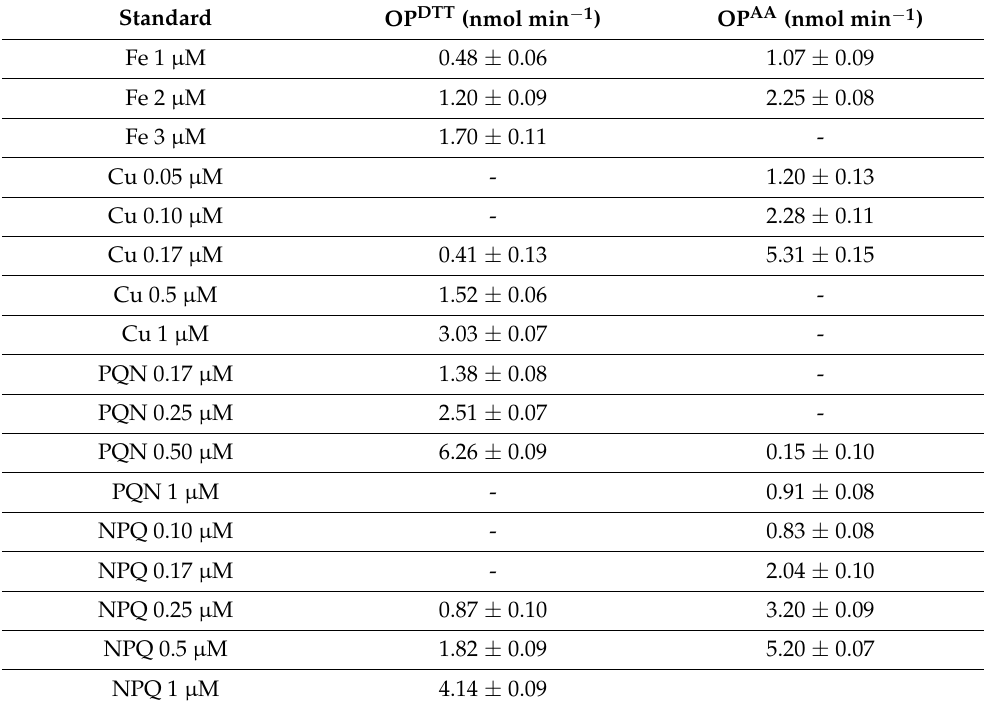
Table 1. Values of DTT and AA consumption (nmol min − 1 ) measured for each individual standard solution at the different concentrations ( µ M represents the number of µ mole L − 1 ) used to prepare the binary